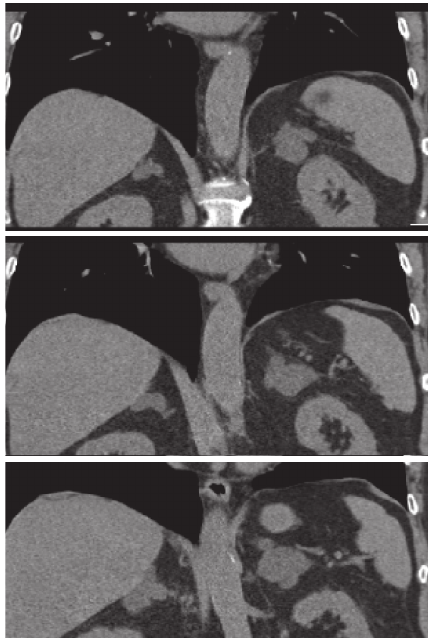
Figure 1: Adrenal CT scan of the index